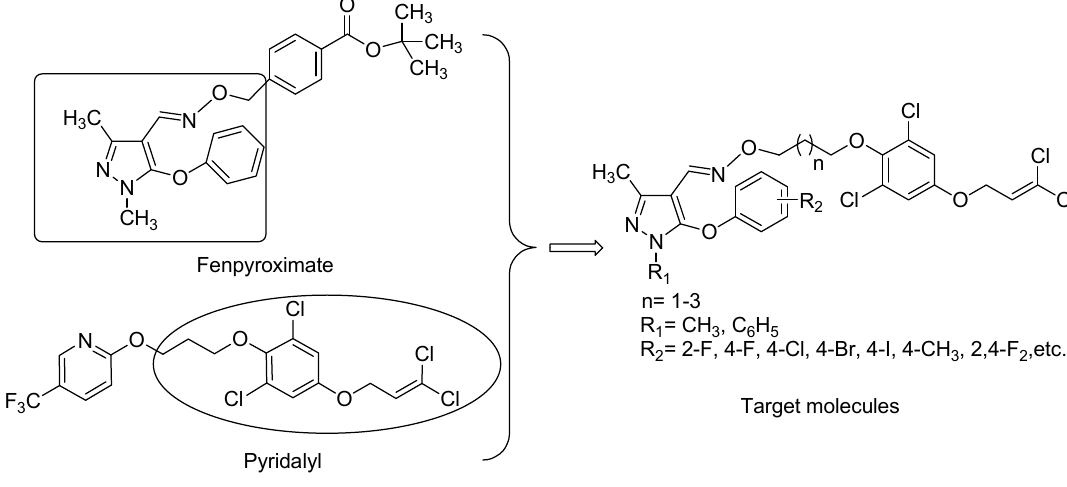
Figure 1. The design of the target molecules.